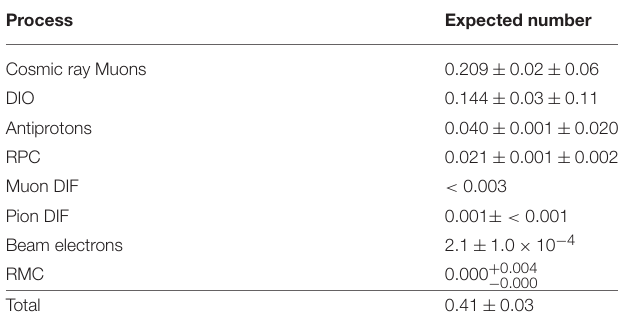
TABLE 1 | Backgrounds in Mu2e for the nominal 3.6 × 10 20 protons-on-target.